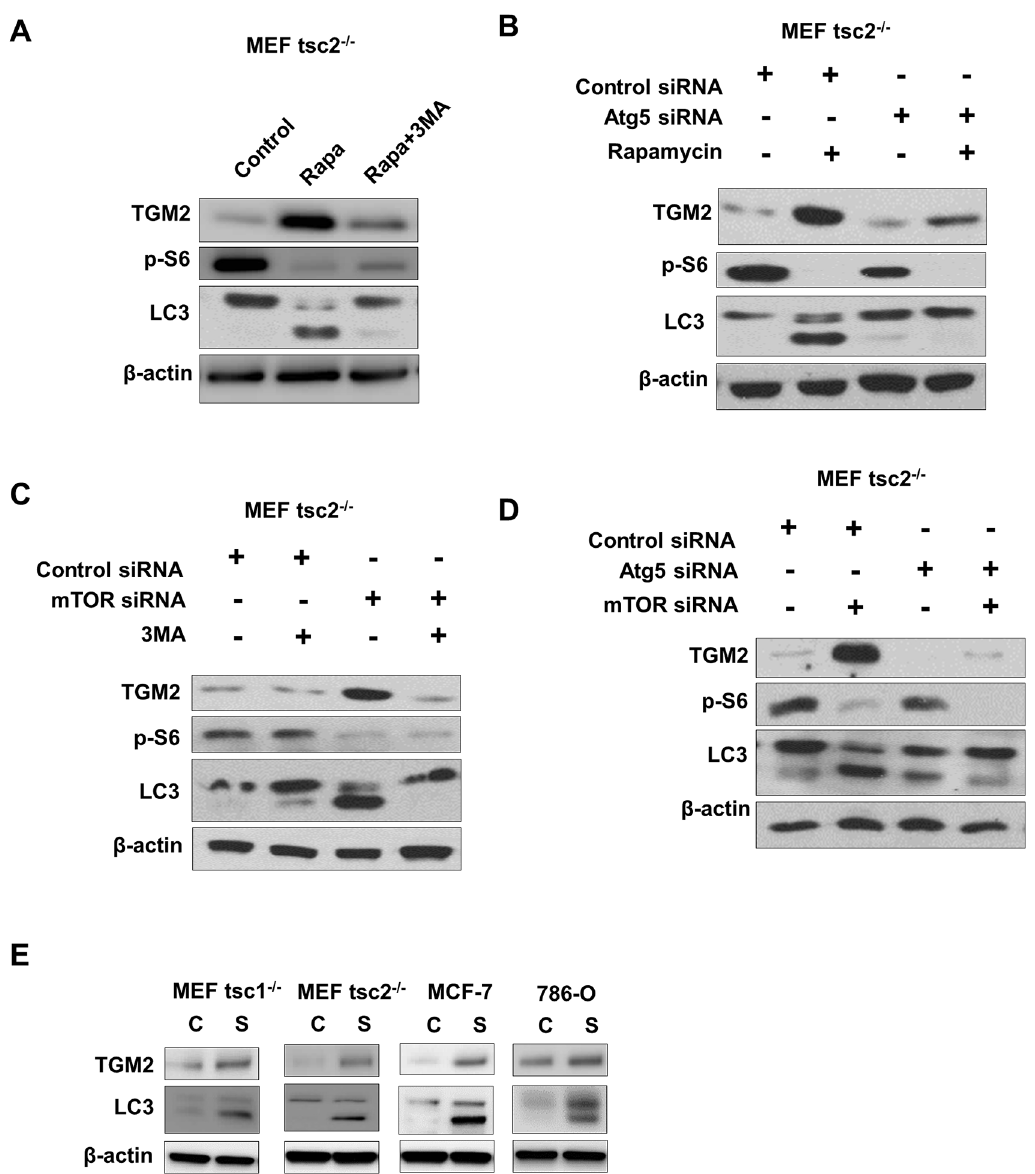
Fig 5. Rapamycin treatment-induced increased TGM2 is autophagy dependent. (A) Immunoblots for TGM2, phospho-S6 and LC3 in vehicle-, rapamycin- and rapamycin plus 3MA-treated Tsc2 -/- MEF cells. (B) Immunoblots for TGM2, phospho-S6 and LC3 in control siRNA-, Atg5 siRNA-, and Atg5 siRNA and rapamycin-treated Tsc2 -/- MEF cells. (C) Immunoblots for TGM2, phospho-S6 and LC3 in control siRNA-, mTOR siRNA-, and mTOR siRNA and 3MA-treated Tsc2 -/- MEF cells. (D) Immunoblots for TGM2, phospho-S6 and LC3 in control siRNA-, mTOR siRNA-, and mTOR and Atg5 siRNA-treated Tsc2 -/- MEF cells. (E) Immunoblots for TGM2 and LC3 in full medium (10% FBS) or starvation (FBS free) condition in Tsc1 -/- and Tsc2 -/- MEFs, MCF-7 and 786-O